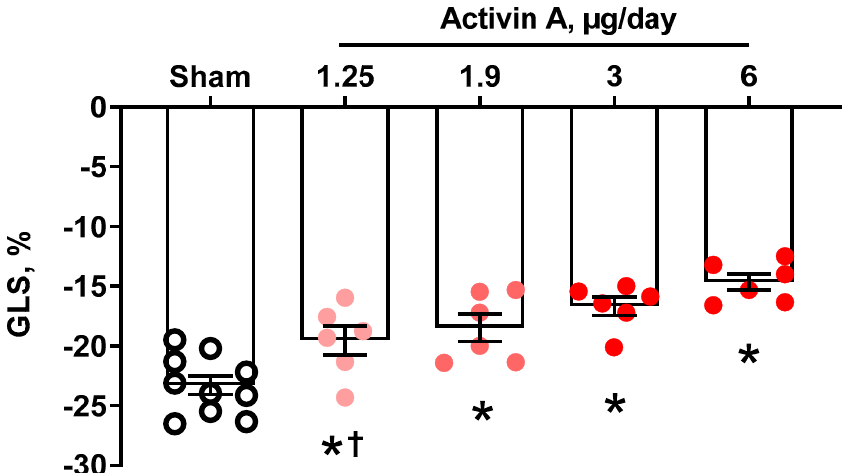
Figure 2. Cardiac global longitudinal strain (GLS) on gestational day 19 in sham (open black circles) and pregnant rats infused with 1.25 µ g/day, 1.9 µ g/day, 3 µ g/day, and 6 µ g/day of human recombinant activin A (solid red circles). Data are mean ± SEM. * p < 0.05 vs. sham, † p < 0.05 vs. 6 µ g/day.